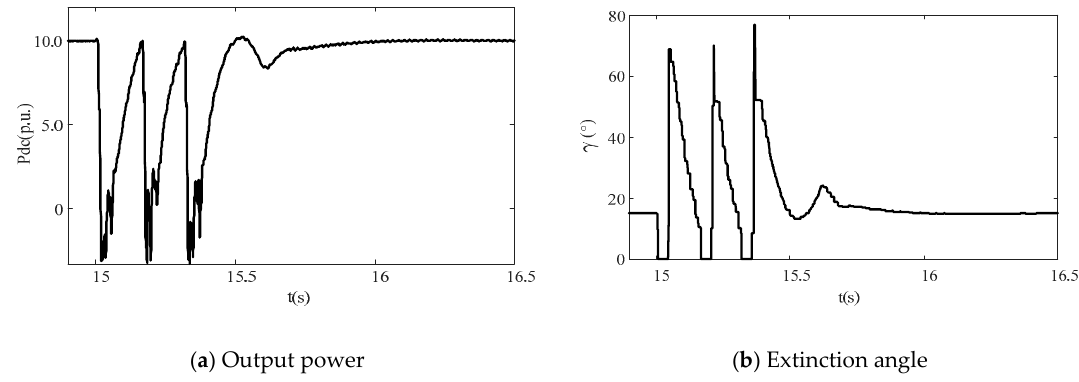
Figure 10. Operation characteristic of DC 1 under continuous CFs.